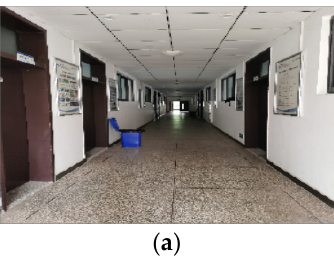
Figure 3. LSD line segment extraction effect: ( a ) indoor promenade scene; ( b , c ): LSD line segment extraction effect.